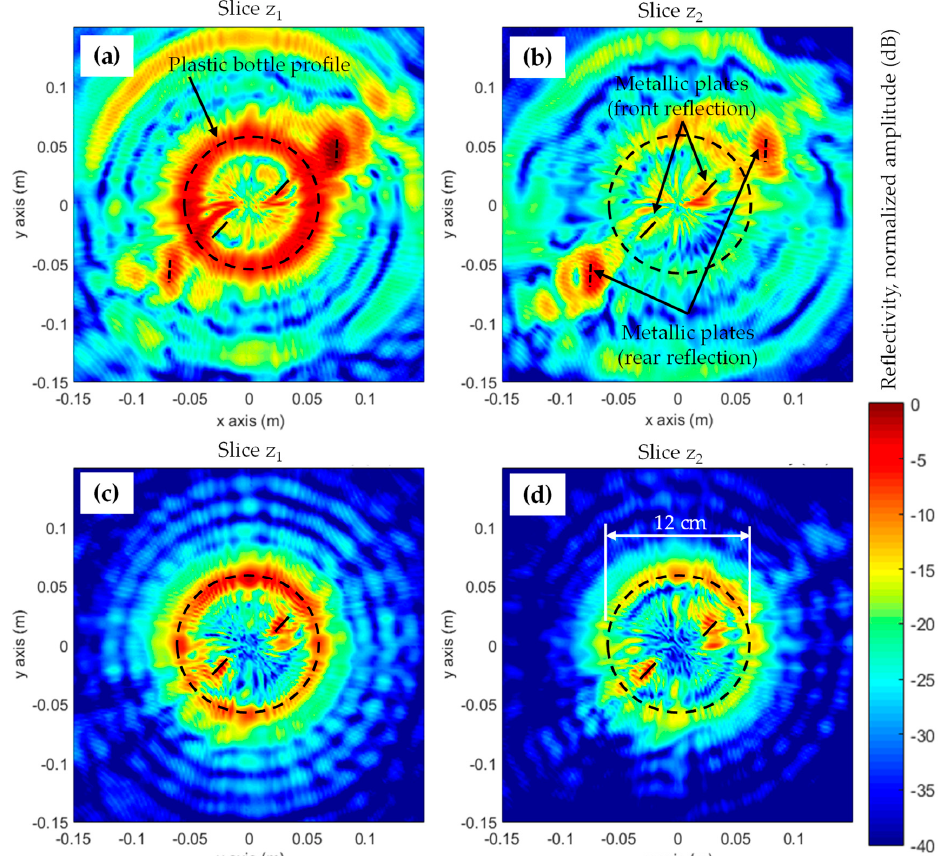
Figure 11. Polar representation of the reflectivity for two different XY slices (z 1 = − 13 cm and z 2 = − 7 cm with respect to the top of the plastic bottle). ( a , b ) Without dielectric delay correction. ( c , d ) After dielectric delay correction, considering ε r,est = 2.5. Dashed line represents the true contour of the plastic bottle. Solid line represents the true position of the metallic plates. In ( a , b ), the straight dashed lines indicate the location of the imaged metallic plates, which appear outside the plastic box contour due to the dielectric delay. Table 1. Constitutive parameters of the media considered in the examples. Comparison with other techniques at microwave frequencies.